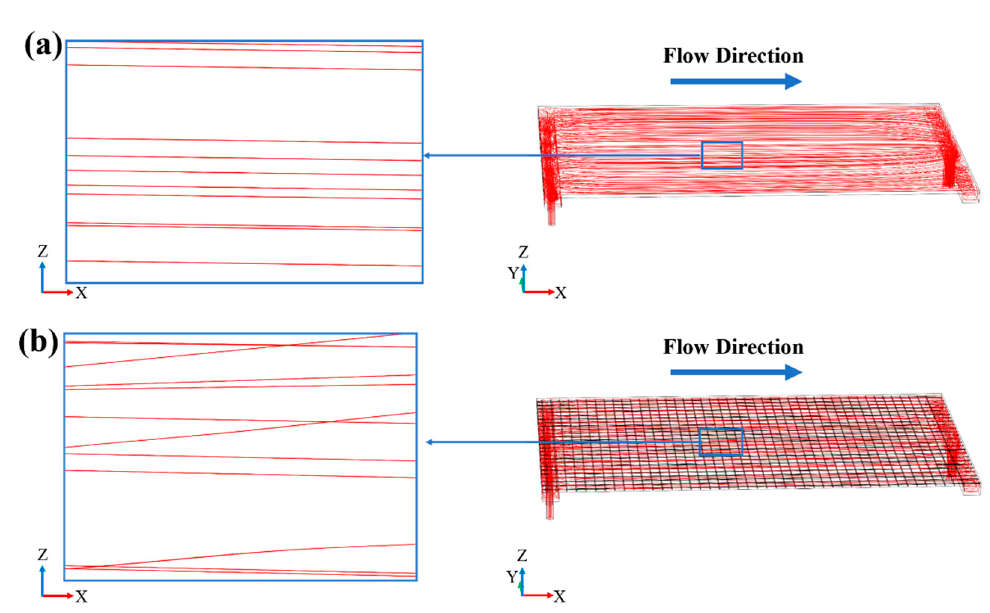
Figure 8. The fluid path line inside the membrane chamber ( a ) without the turbulence promoter and ( b ) with the turbulence promoter (inlet velocity = 8 m/s).